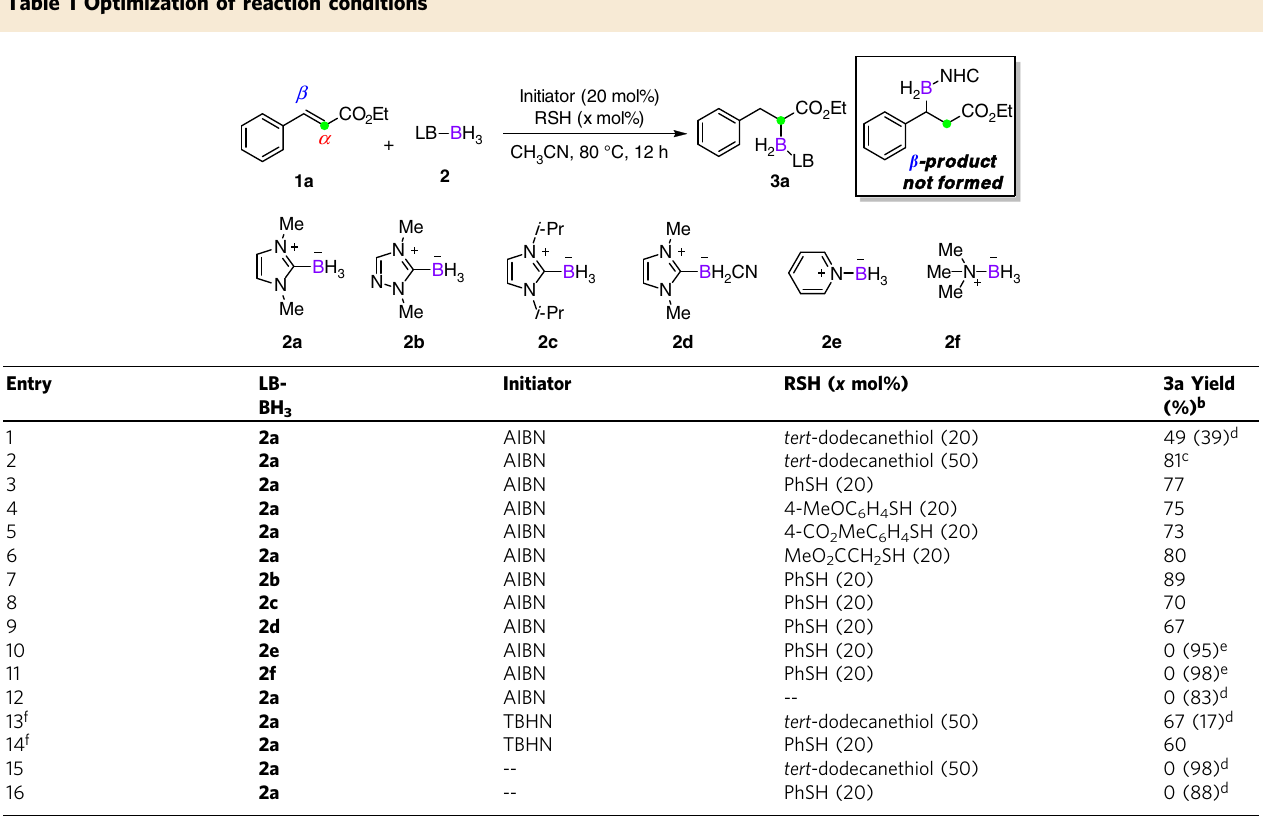
Table 1 Optimization of reaction